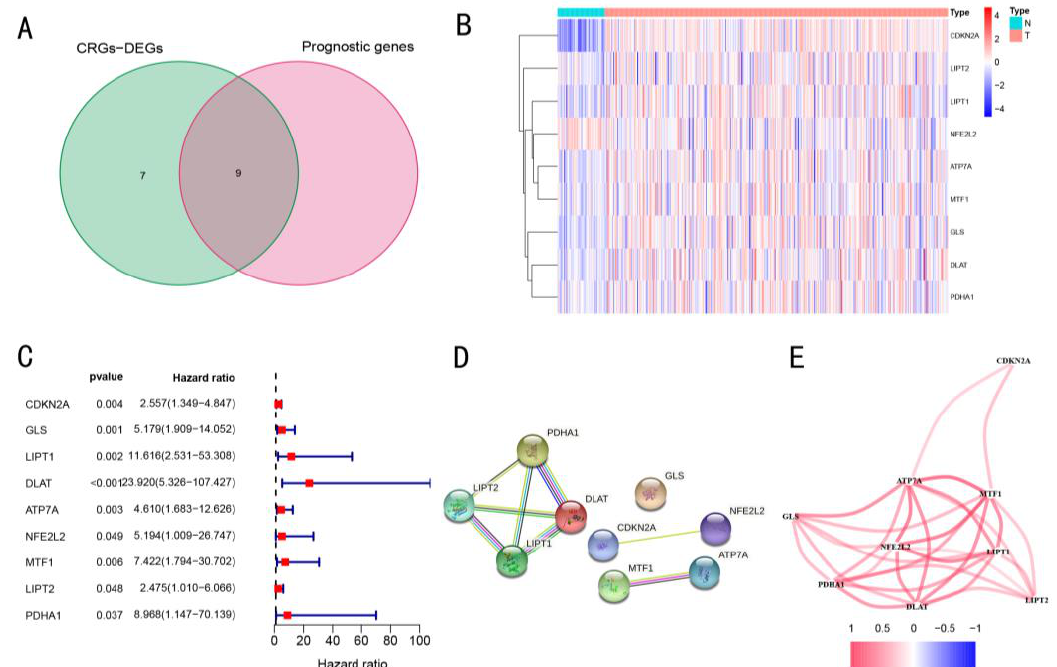
Figure 2. Identification of CRGs for follow-up studies. ( A ) Venn diagram of the intersection of CRGs-DEGs and cuproptosis-related prognostic genes in tumor and non-tumor tissues. ( B ) The heatmap shows the comparison of the expression amount of intersection genes in tumor (T) and non-tumor (N) tissues. ( C ) Forest plot shows the risk degree of each intersecting gene using the univariate cox regression analysis. ( D ) Interactions between the nine genes were presented using the PPI network for further study. ( E ) Correlation network shows the correlations between the expression levels of nine genes with positive correlation shown in warm colors.